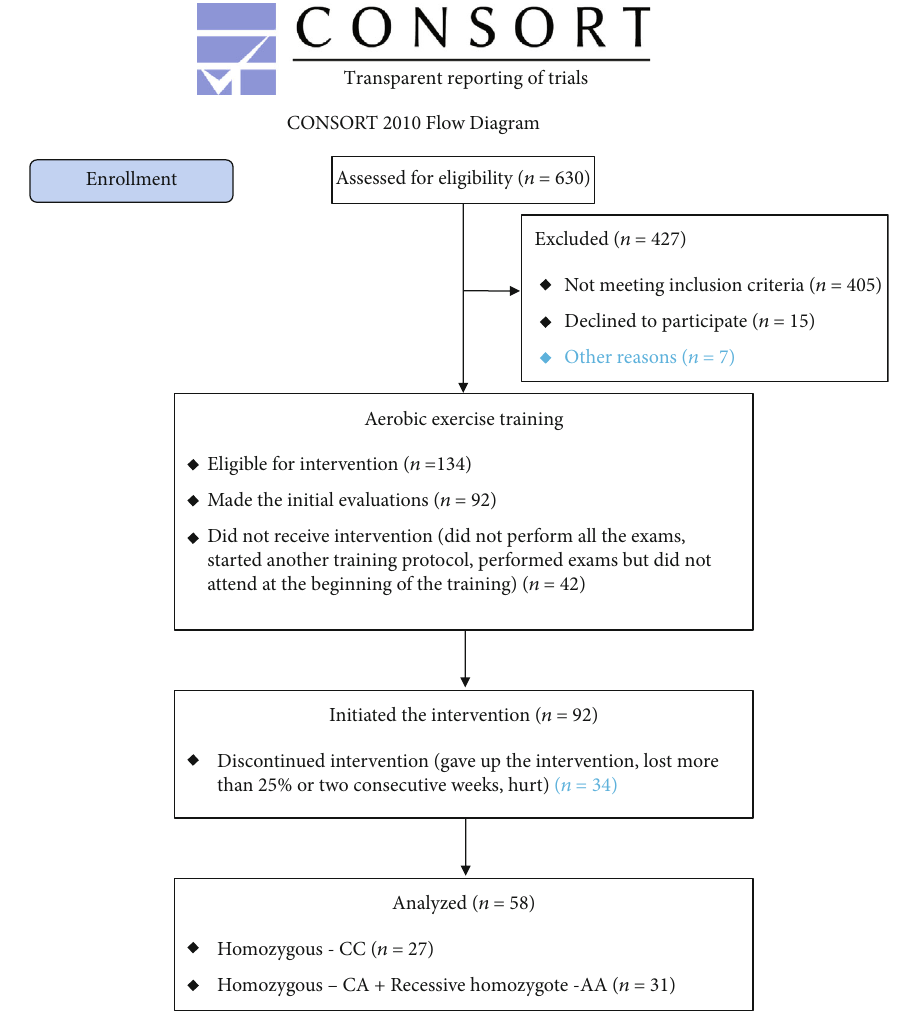
Figure 1: CONSORT fl ow diagram.